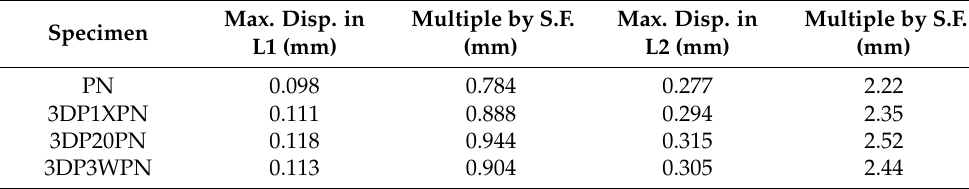
Figure 17. Wind pressure–displacement diagram of the model in the original area. Table 7. Lateral load test results.